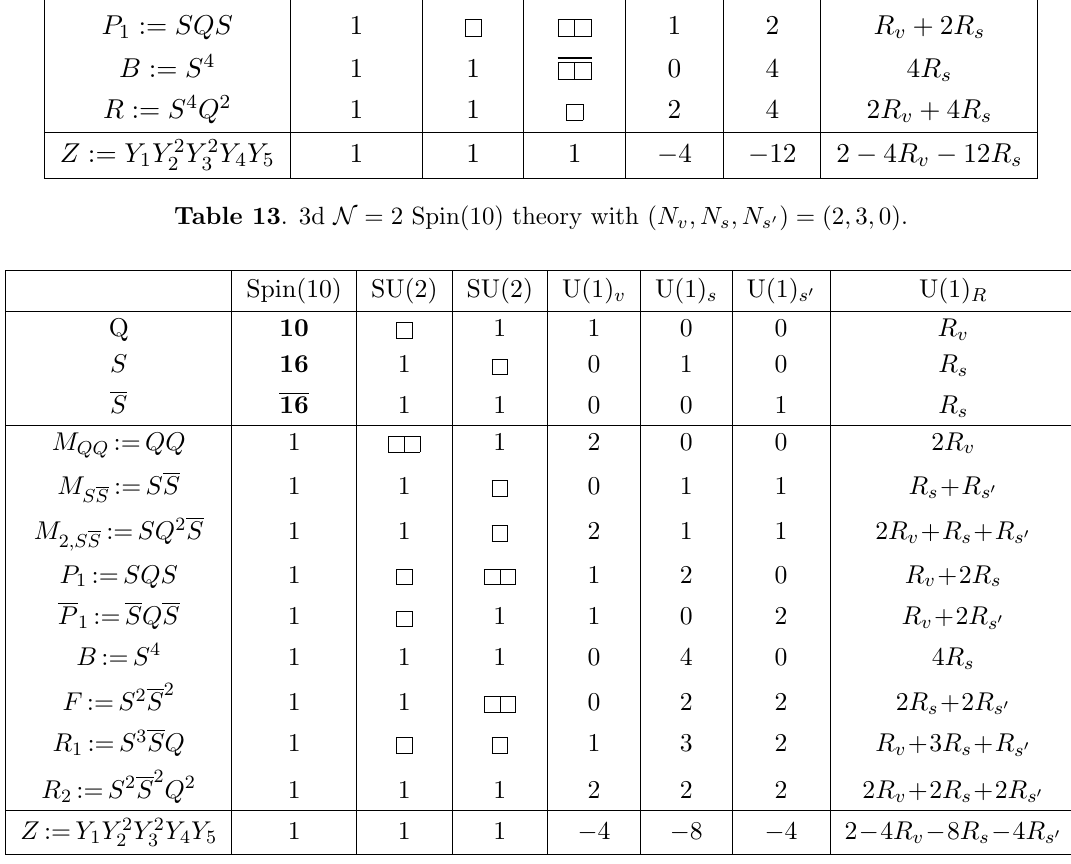
Table 14 . 3d N = 2 Spin(10) theory with ( N v ; N s ; N s 0 ) = (2 ; 2 ;